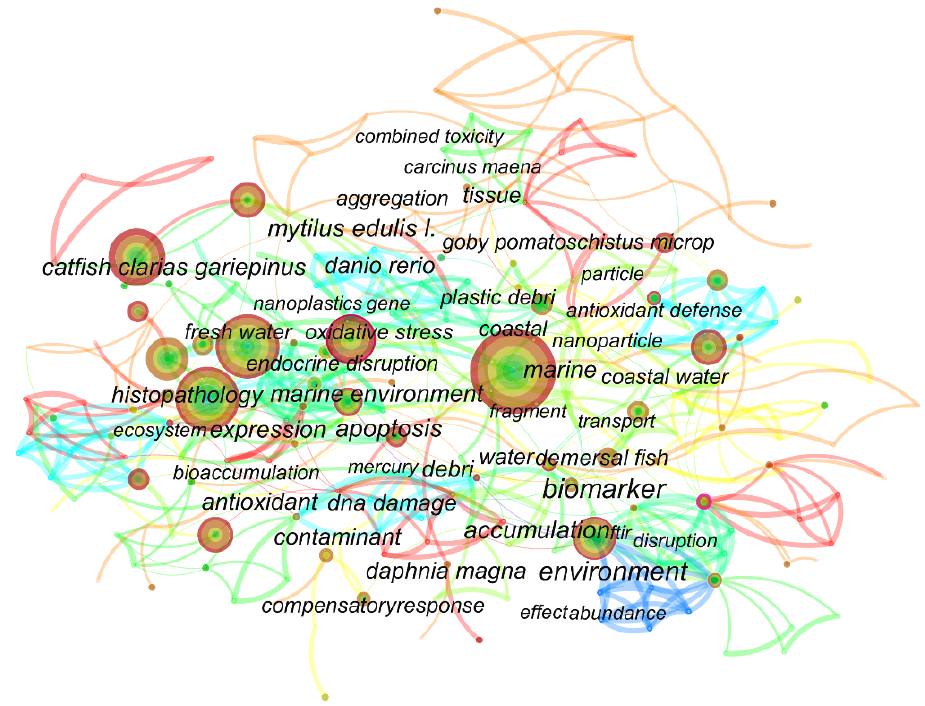
Figure 1. Keyword co-occurrence analysis.